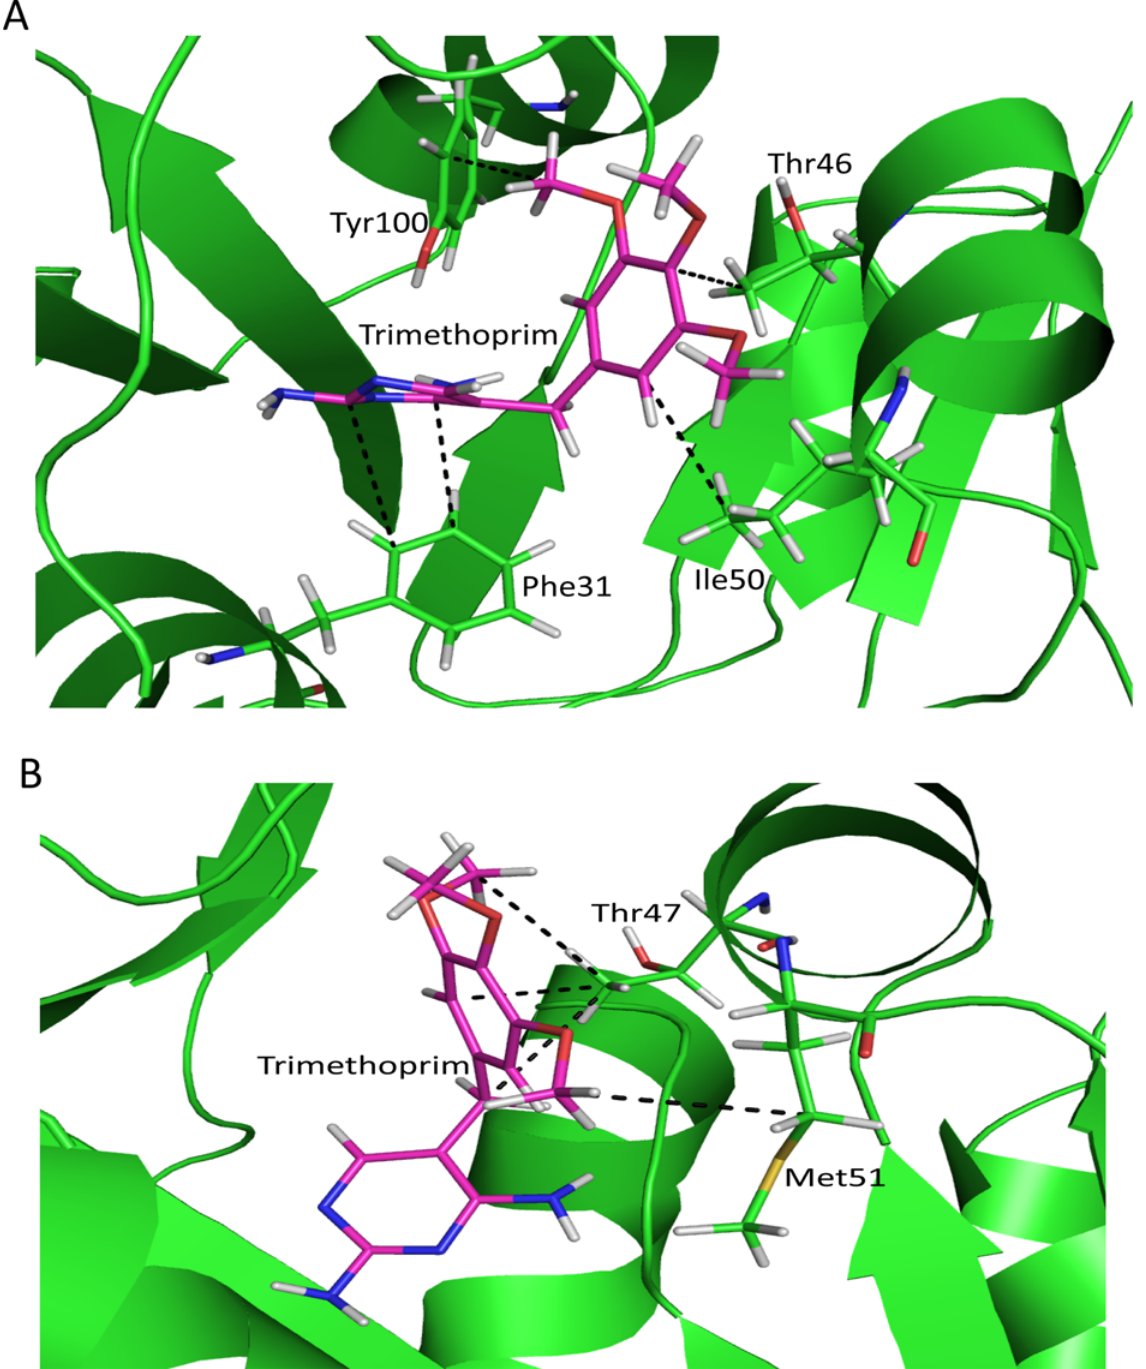
Fig 6. Hydrophobic interaction between ligand and protein active site residues. Dash line shows hydrogen bond between, trimethoprim (magenta) and protein active site residues (green), A) TMP-sensitive-Dfr-TMP complex, B) PGB01-DfrA7-TMP complex.